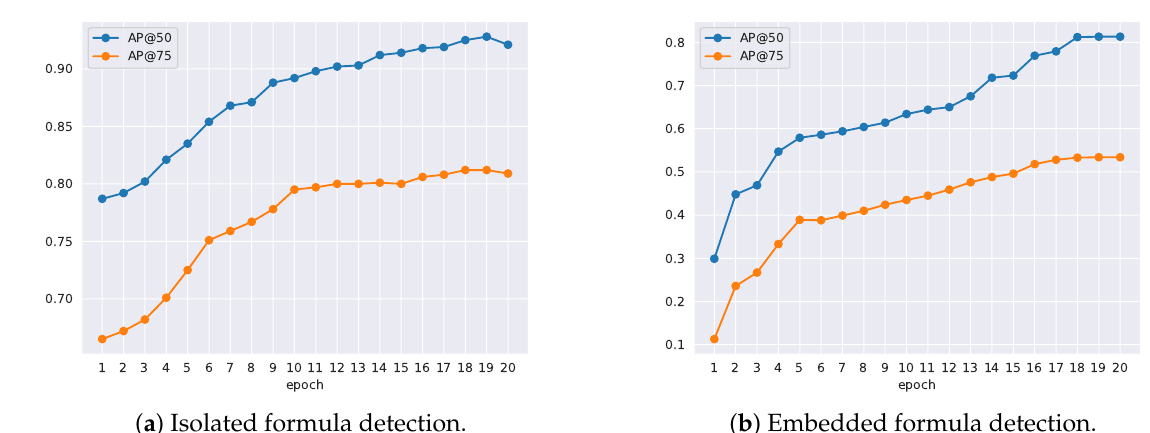
( b ) Embedded formula detection. Figure 10. Performance evaluation of the proposed method on the Marmot dataset in terms of average precision (AP) at an IoU threshold of 0.5 and 0.75. ( a ) represents the the evolution of AP on isolated formulas, whereas ( b ) exhibits the the evolution of AP on embedded formulas.